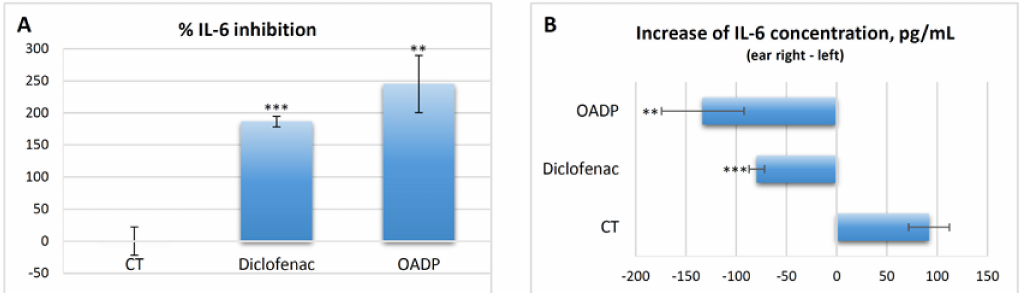
Figure 10. IL-6 inhibition percentage, calculated from the differences between the left and right ears in the different groups of mice ( A ). Increases in IL-6 concentration (pg/mL) calculated from the differences between the left and right ears in the different groups of mice (control, diclofenac and OADP) ( B ). The mean ± S.E.M. is shown for each of these parameters ( n = 4). Key: (**) p < 0.01 and (***) p < 0.001, with respect to the control group of